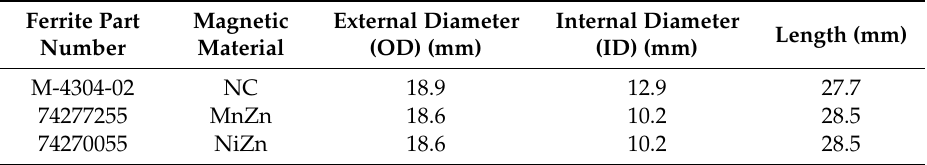
Table 1. Lists of sleeve ferrite cores used in this